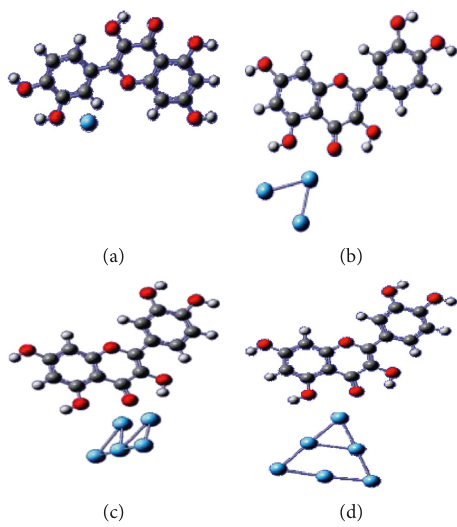
Figure 6: Optimized geometries of quercetin with (a) a single silver atom, (b) cluster of 3 silver atoms, (c) cluster of 5 silver atoms, and (d) cluster of 6 silver atoms.